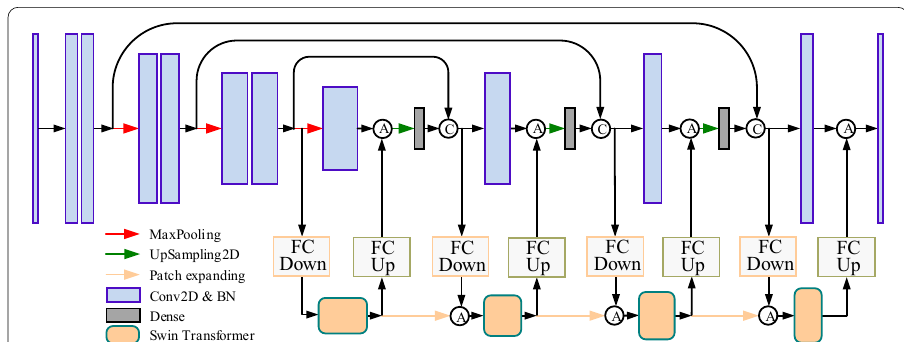
Fig. 2 Structure diagram of the proposed